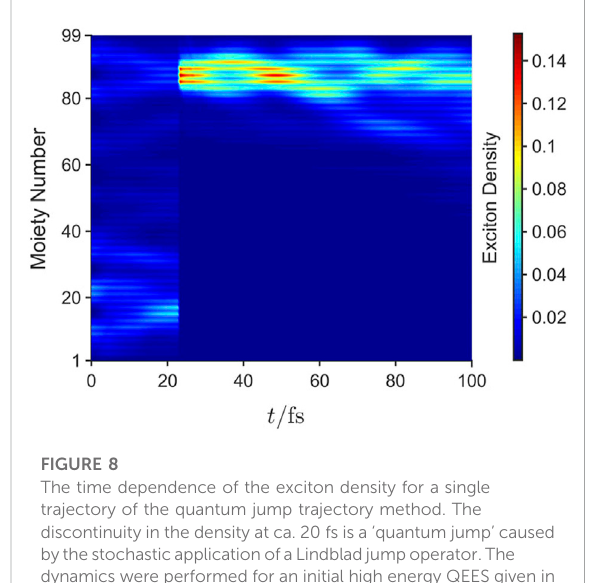
FIGURE 8 The time dependence of the exciton density for a single trajectory of the quantum jump trajectory method. The discontinuity in the density at ca. 20 fs is a ‘ quantum jump ’ caused bythestochasticapplicationofaLindbladjumpoperator.The dynamics were performed for an initial high energy QEES given in Figure 2B, showing localization onto the LEGSs (i.e., a chromophore) labeled j = 2 in Figure 2A. Reproduced from J. Chem. Phys. 148, 034901 (2018) with the permission of